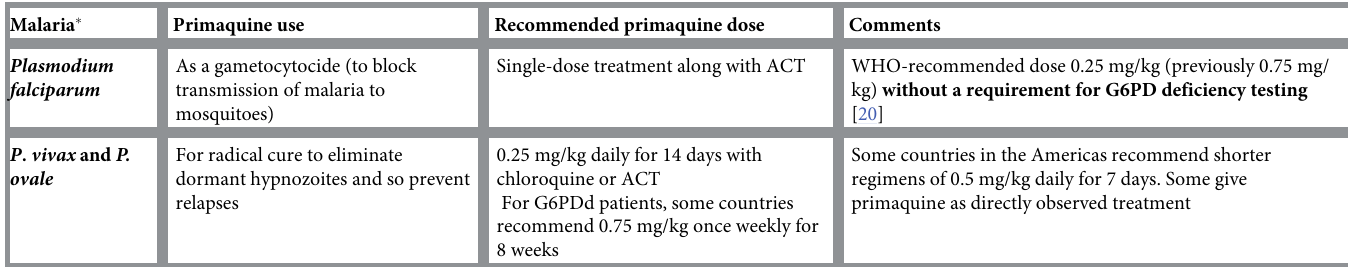
Table 2. Primaquine for malaria